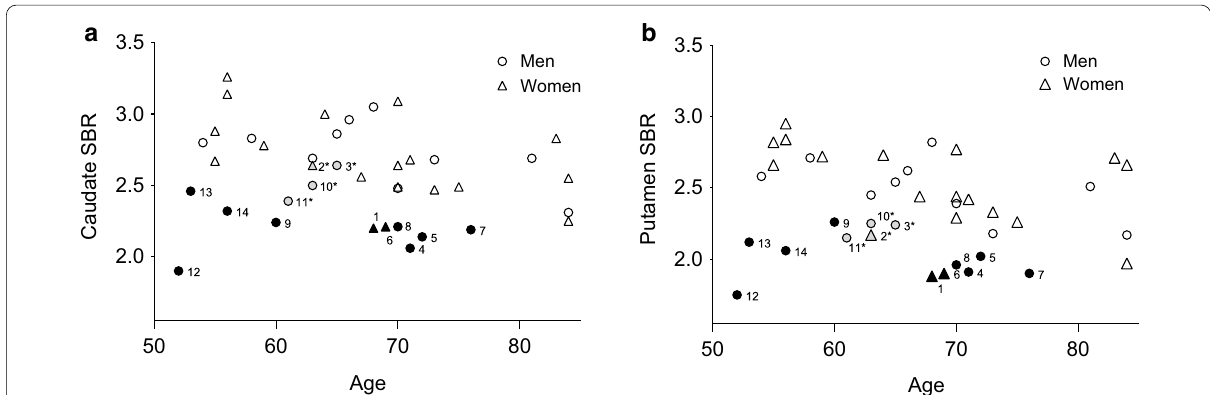
Fig. 1 Specific binding ratios (SBRs) in A caudate nucleus and B putamen in healthy women and men with abnormal DAT binding (men circle, women solid triangle), with borderline DAT binding (men = circle, women open triangle). Corresponding subject numbers with abnormal and borderline (*) DAT binding are presented in Table 2 =